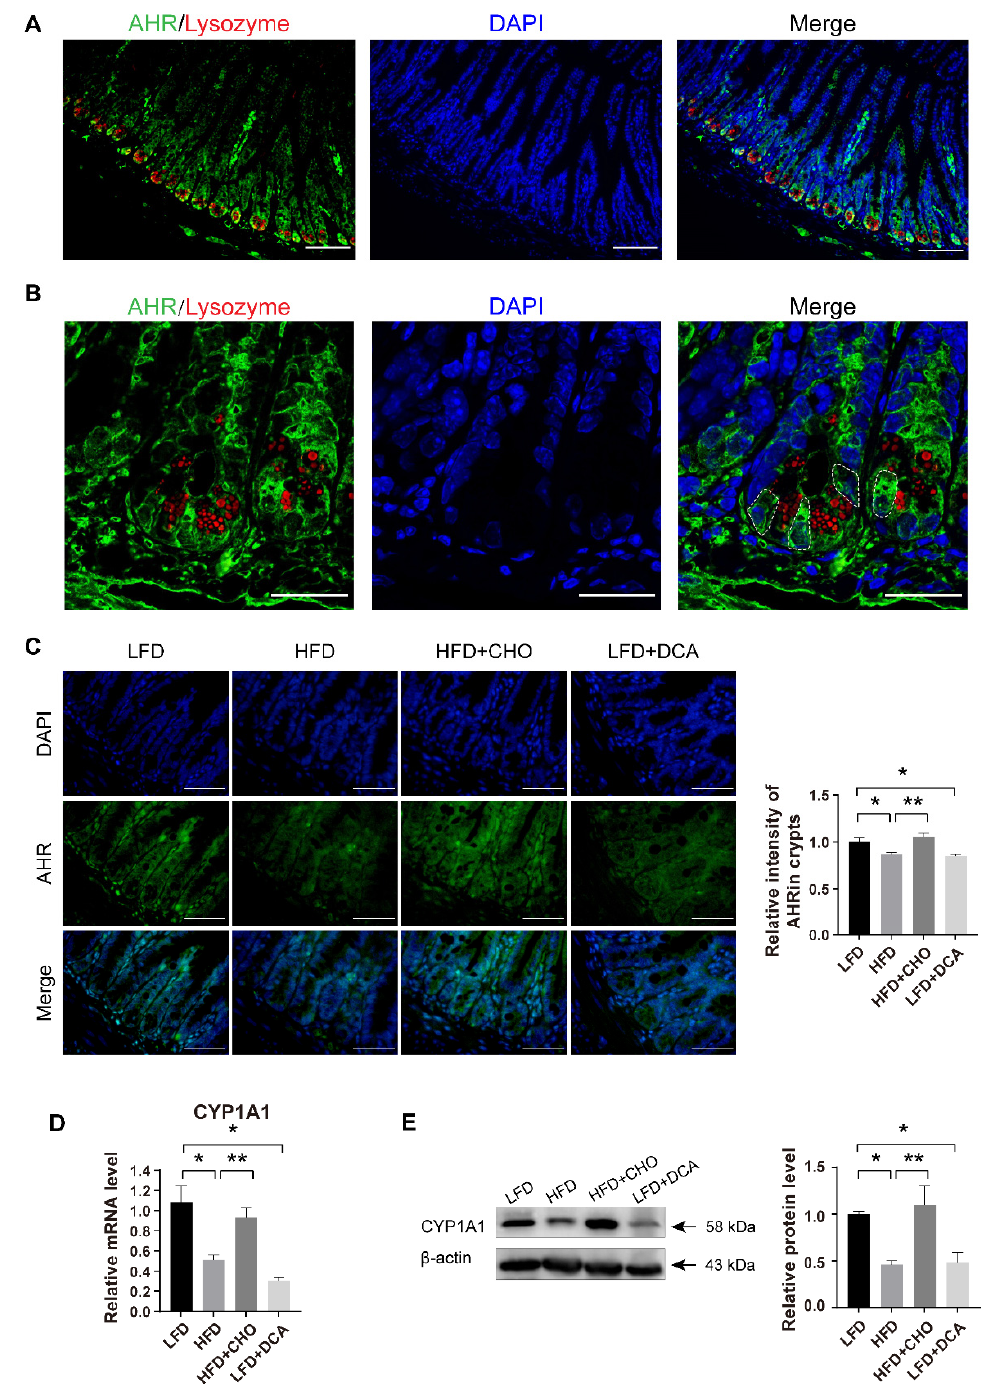
Figure 3. Elevated DCA induced by an HFD disrupts AHR signalling in ISCs. ( A , B ) Immunofluorescence staining images of DAPI (blue), AHR (green) and the Paneth cell maker lysozyme (red) in ileal tissue ( A ) and ileal crypts ( B ). The white dashed line indicates the location of the ISCs. Scale bars, 100 μ m ( A ) and 25 μ m ( B ). ( C ) Representative immunofluorescence images of AHR and analysis of fluorescence intensity in different groups (n = 5); scale bars, 100 μ m. ( D ) The mRNA expression levels of the AHR downstream gene CYP1A1 in the ileum in different groups (n = 4). ( E ) Relative protein levels of CYP1A1 in ileal tissue and analysis in different groups (n = 5). Data are shown as the mean ± SEM. n = 5. AHR, aryl hydrocarbon receptor; ISCs, intestinal stem cells; LFD, low ‐ fat diet; HFD, high ‐ fat diet; CHO, cholestyramine; DCA, deoxycholic acid. * p < 0.05; ** p < 0.01.